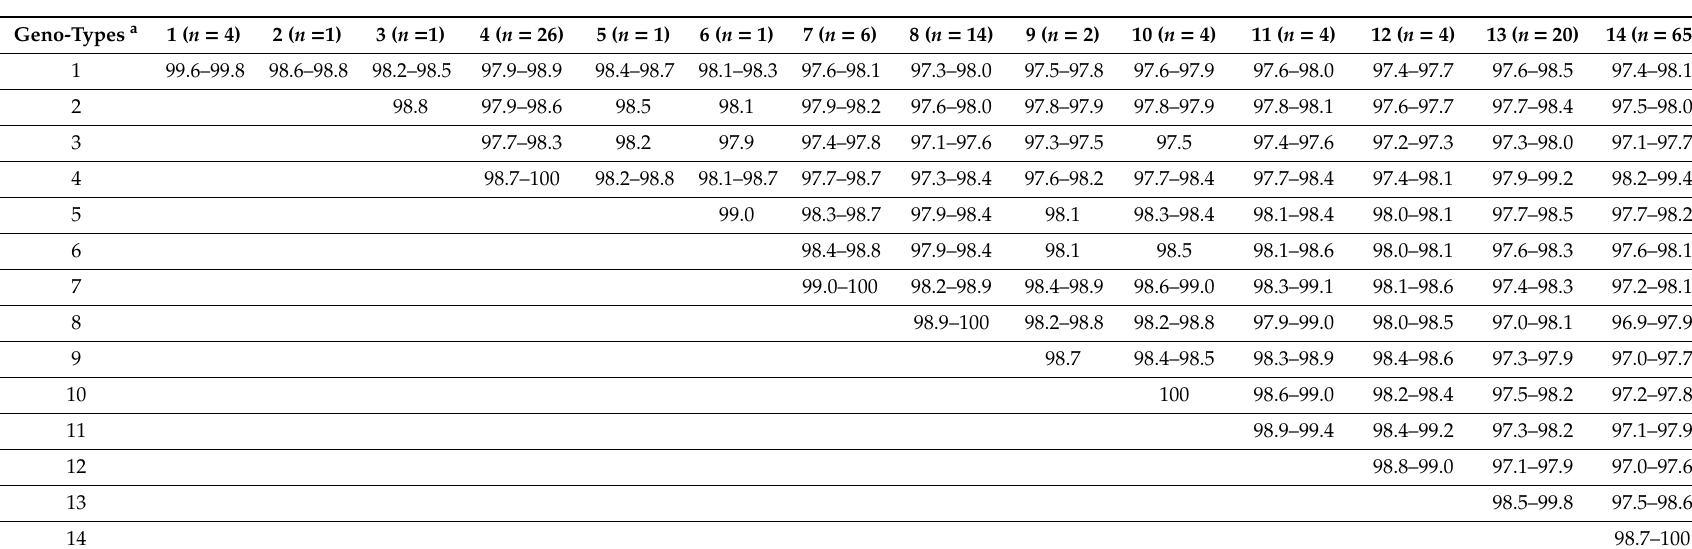
Table 2. Sequence identities (%) among 14 genotypes that classified using complete sequences of spike glycoprotein (S) genes from 153 American, European, and Asian BCoV strains including BCoV-like human enteric coronavirus at nucleotide